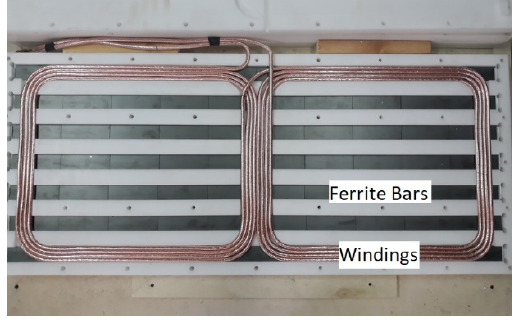
Figure 12. Experimental coil layout.